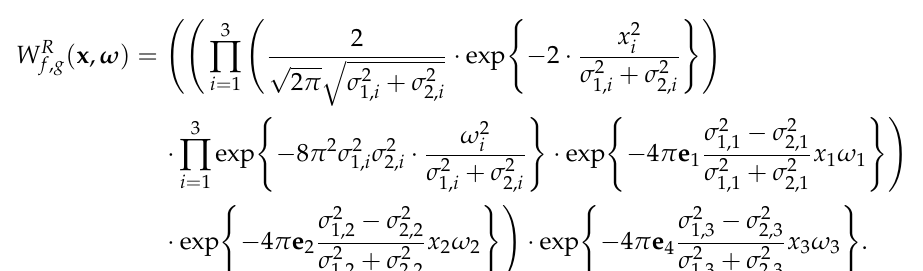
(cid:16) (cid:17) 1 , 1 , 1 . 4 4 4